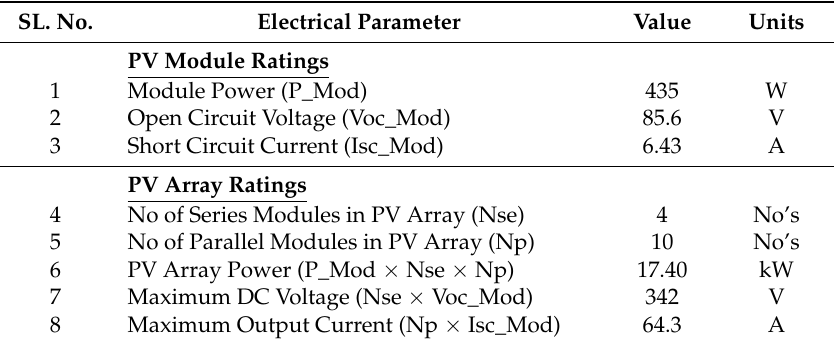
Table 2. Parameters of Selected PV-Array to Be